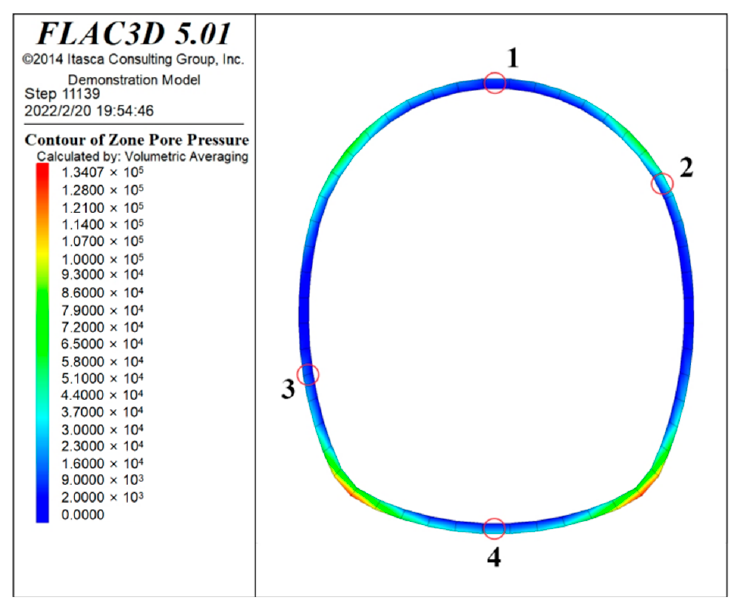
Figure 1. The external water pressure of initial support of the sub ‐ sea tunnel (unit: Pa). Table 1. The calculation results of initial support external water pressure.